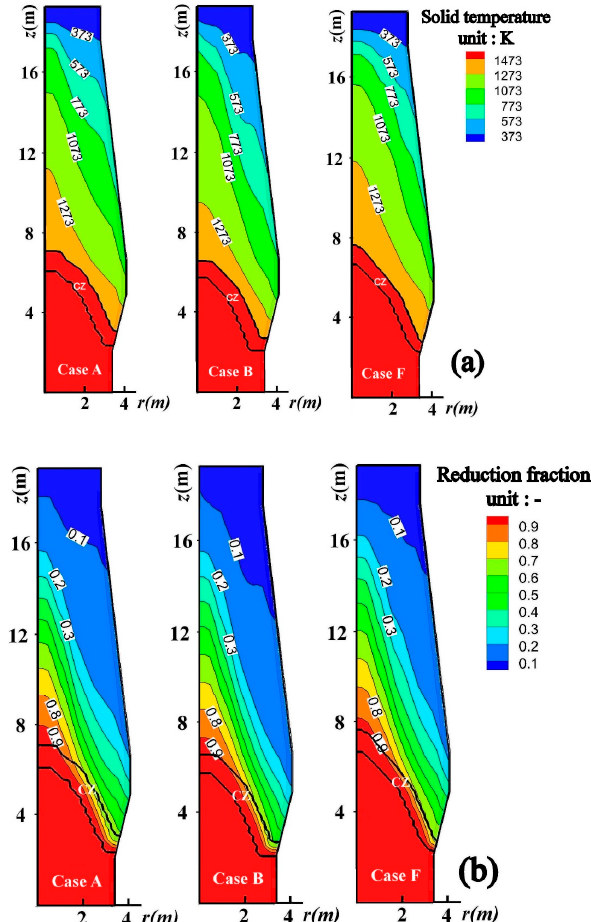
Figure 3. Simulation results of solid phase in the BF of cases A, B, and F: ( a ) Profile of solid-phase temperature; and ( b ) profile of sinter reduction fraction.